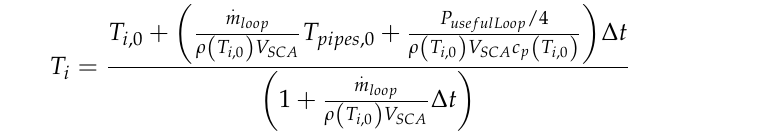
Figure 3. Electric efficiency of the power block as a function of the useful thermal power from the solar field ( 𝑃 (cid:3046)(cid:3033) ).